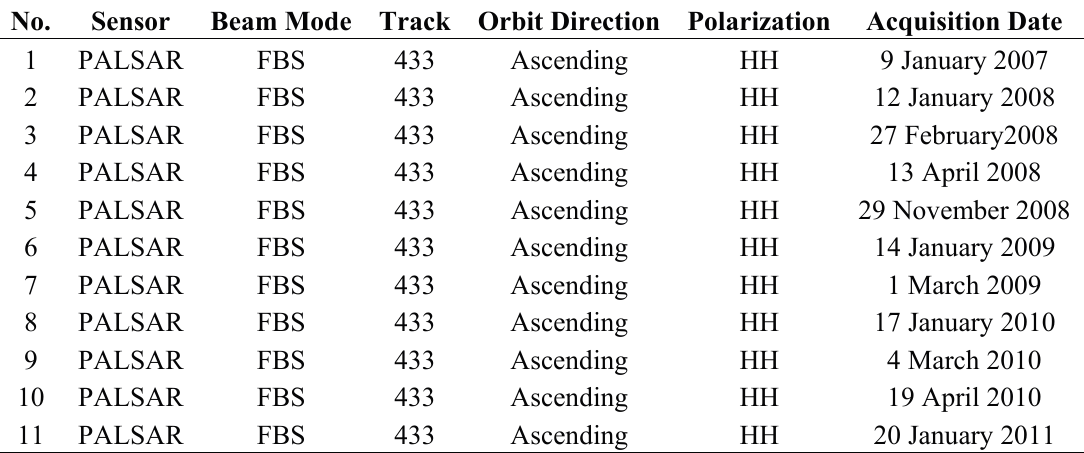
Table 1. Summary of the used synthetic aperture radar (SAR) data provided by the phased array type L-band synthetic aperture radar (PALSAR) sensor onboard the advanced land observing satellite